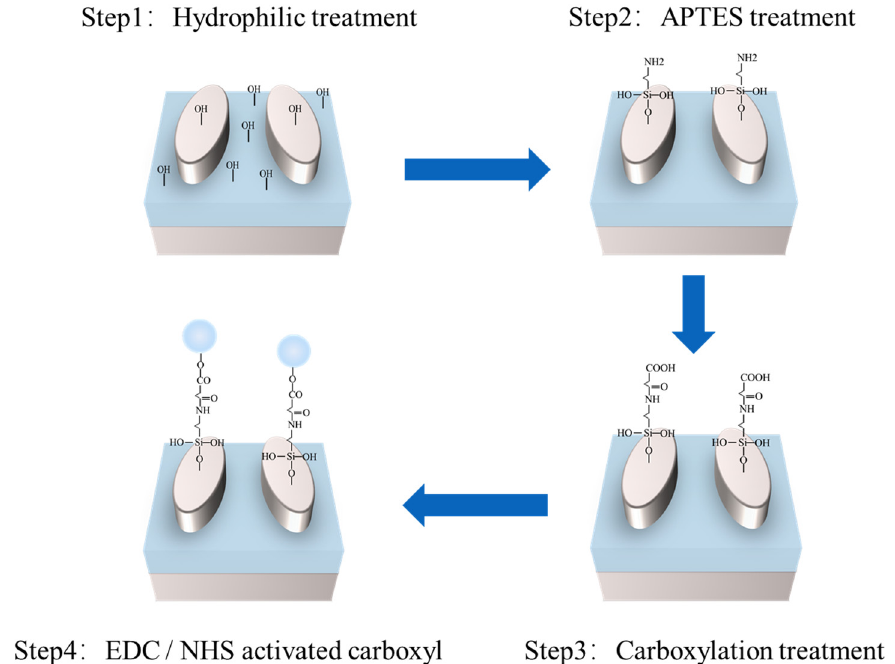
Figure 1. Schematic diagram showing the steps to attach MC-LR to the surface of a dielectric metasurface.